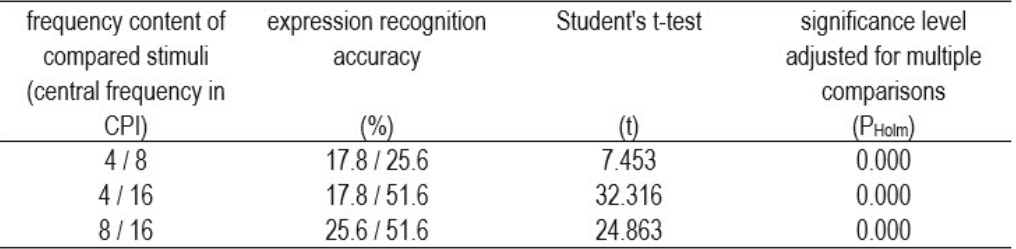
Comparison of expression recognition accuracy for stimuli with a bandwidth of 1